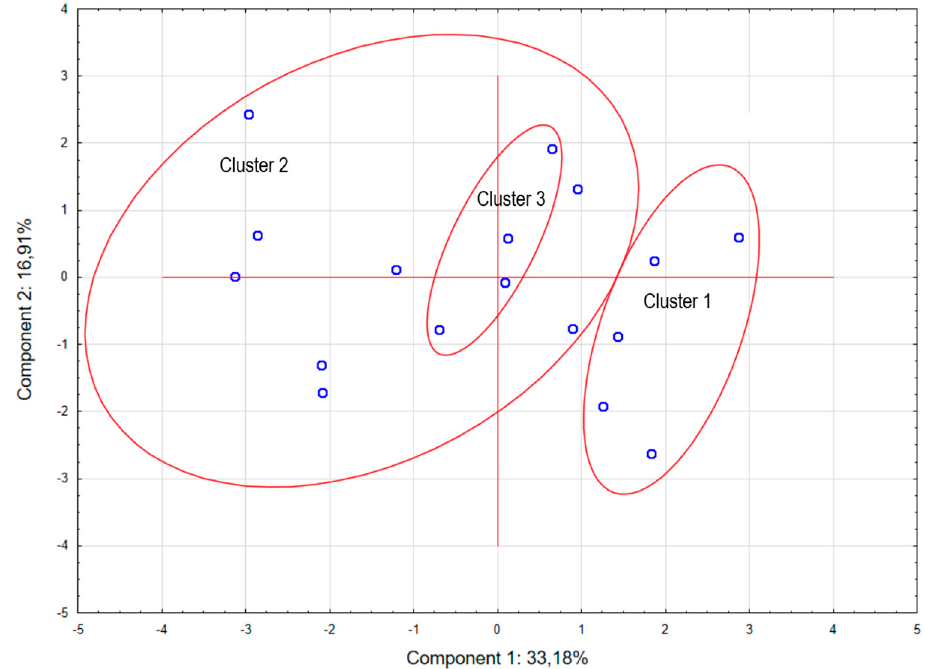
Figure 2. The effects of cluster analysis using the K-means method. Table 4. Mean values for clusters obtained from the cluster analysis using the K-means method.